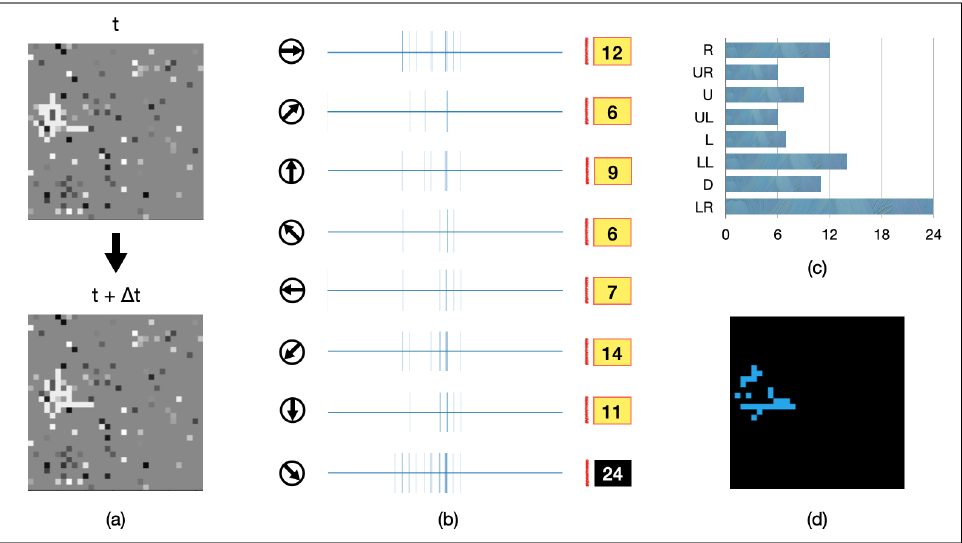
Figure 13. An AVS motion direction detection instance in static full-image noise: ( a ) two successive frames of a lower rightward motion of an 32-pixel object; ( b ) activation map of the eight LMDNs during scan; ( c ) LMDNs activations are counted by a bar chart; ( d ) activated pixels by all the LMDNs during detection process are marked by